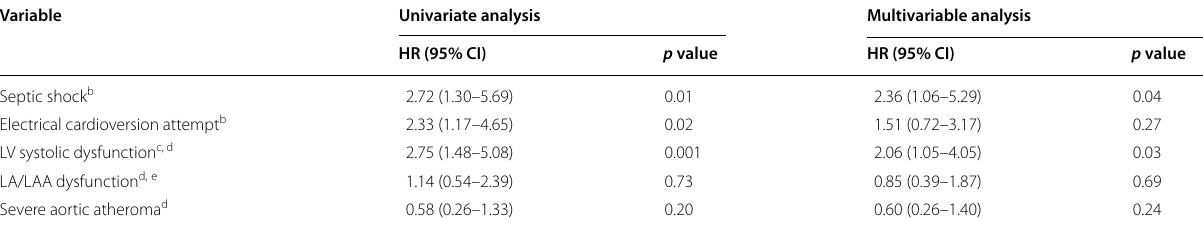
Table 4 Univariate and multivariable analyses of factors associated with cardiovascular events a